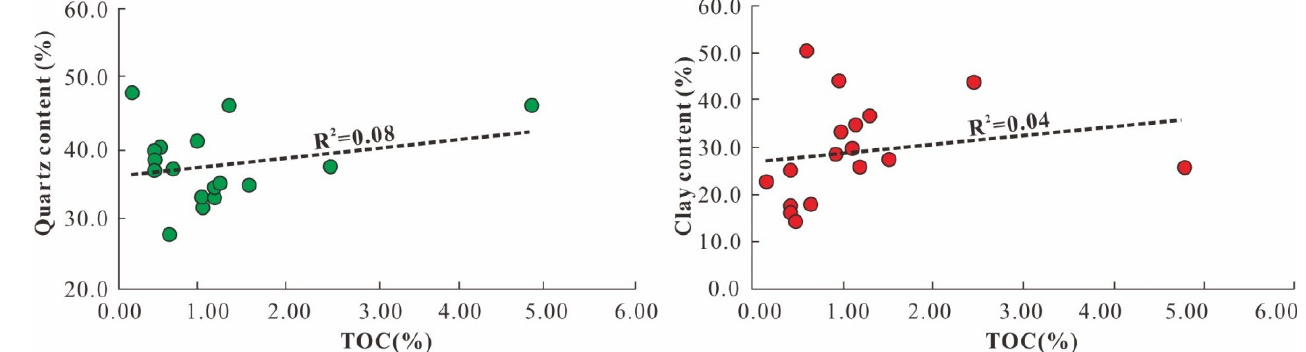
Figure 8. Relationship between TOC and mineral content within shale.